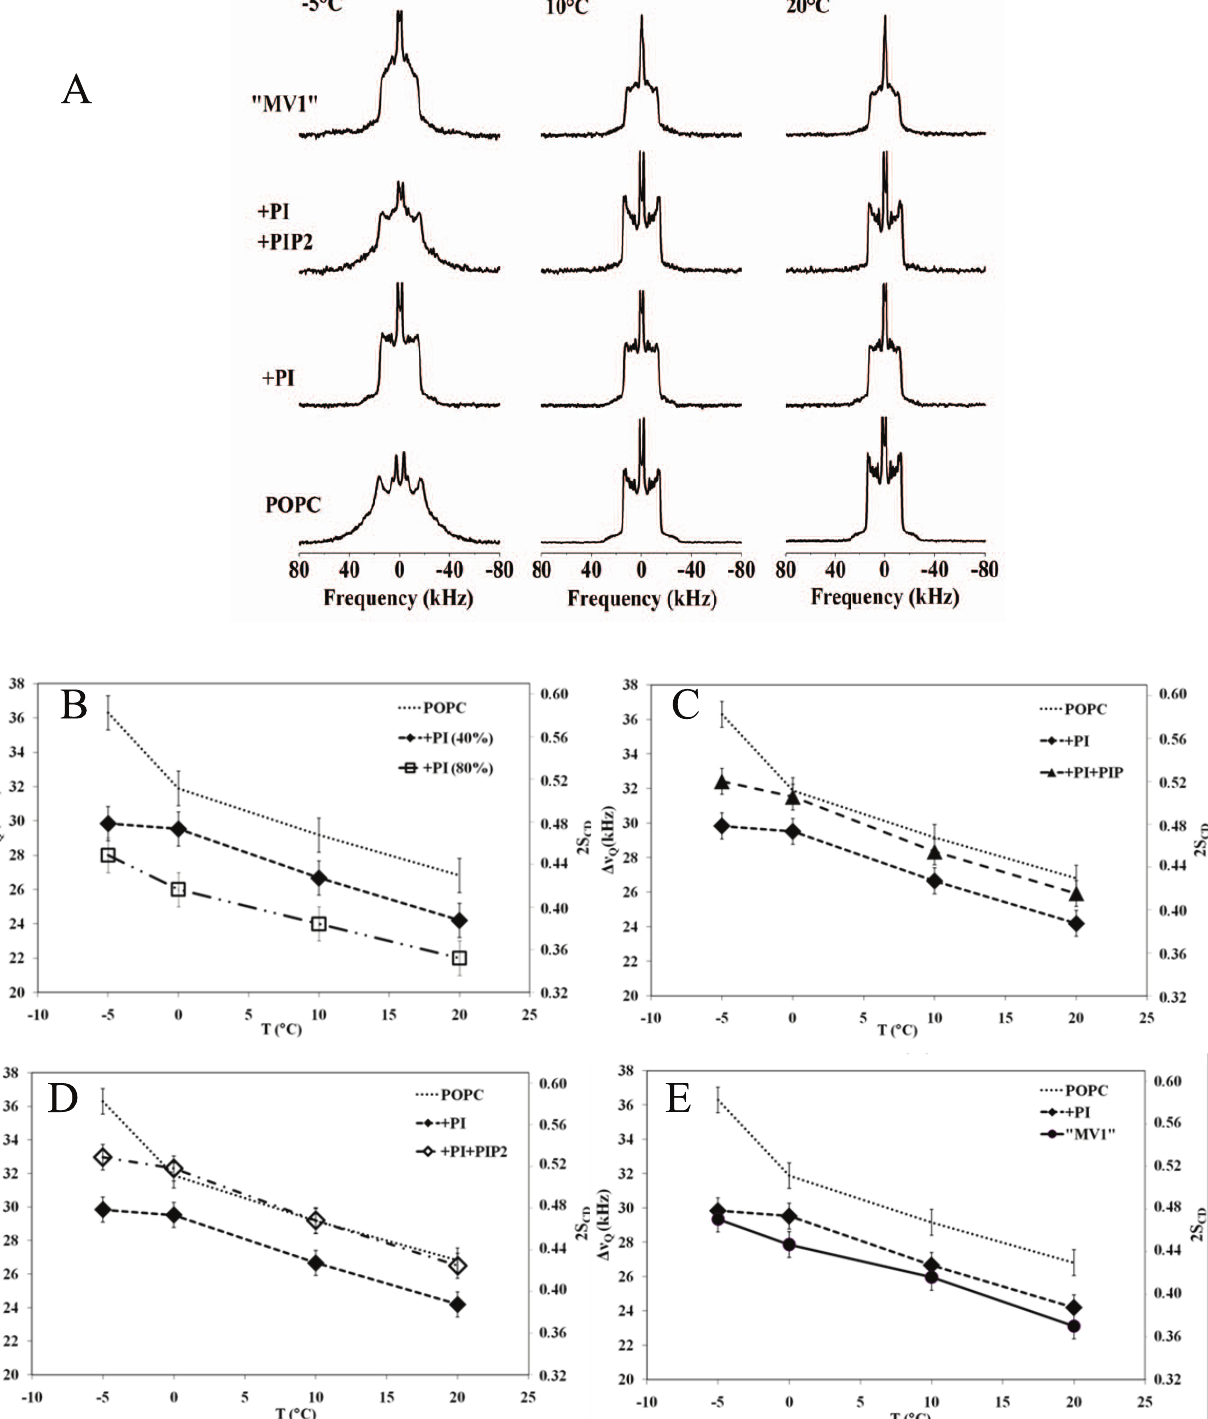
Figure 1. Core fluidity of ptdcho/ptdins model membranes by deuterium wide-line nmr spectroscopy. A-Representative deuterium wide-line NMR spectra of POPC- 2 H 31 in the absence (bottom) or presence of different PtdIns. The molar ratios are representative of the lipid composition found in MV1: POPC/PtdIns (30/20), POPC/PtdIns/PtdInsP 2 (30/20/12), and MV1-like: POPC/PtdIns/PtdInsP/PtdInsP 2 (30/20/18/12). Temperatures are indicated on spectra. Sample hydration (water mass/water + lipid mass) is 95%. Depending on POPC amounts (1–3 mg), each spectrum is the result of 10 k to 80 k cumulative scans. A Lorentzian filtering (LB) of 200–300 Hz was applied prior to Fourier transformation. FIG. 1B– D Ordering of chain segments close to glycerol backbone, MV1-like membranes. Thermal variation of the plateau (k=2 to 8–10) quadrupolar splittings of POPC, POPC/PtdIns (30/20 and 10/40) panel B; POPC/PtdIns/PtdInsP (30/20/18), panel C); POPC/PtdIns/PtdInsP 2 (30/20/12), panel D; and MV1-like model membranes POPC/PtdIns/PtdInsP/PtdInsP 2 (30/20/18/12), panel E. For comparison, data for pure POPC and POPC/PtdIns (30/20) membranes was added to the graph for the three last compositions. Accuracy of the measure is 6 1 kHz. On the double Y-axis the corresponding